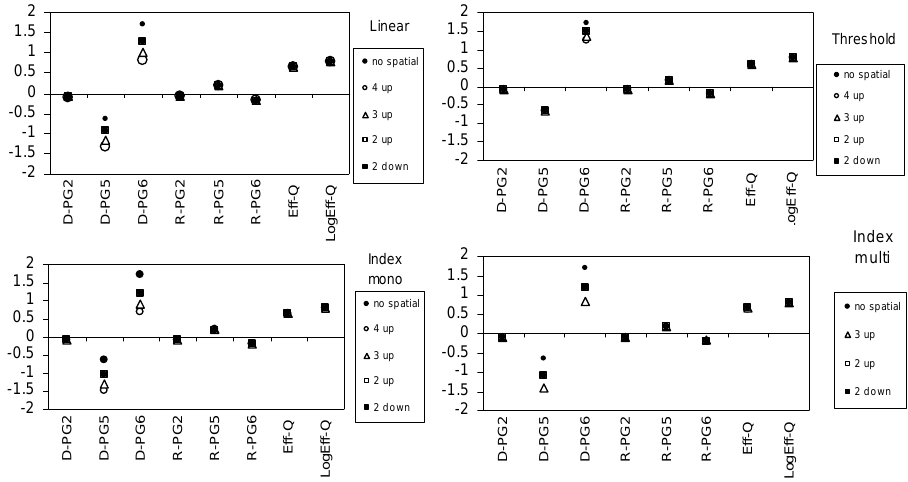
Figure 9. Mean error (D) and log of relative range of variations (R) of water table depth, computed for a reference case considering a different range of spatial variation of saturated hydraulic conductivity from the top to the bottom and reverse, during the tested period, for three wells – PG2 (bottom), PG5 (midslope) and PG6 (plateau) – and different spatial models of variation in hydraulic conductivity.